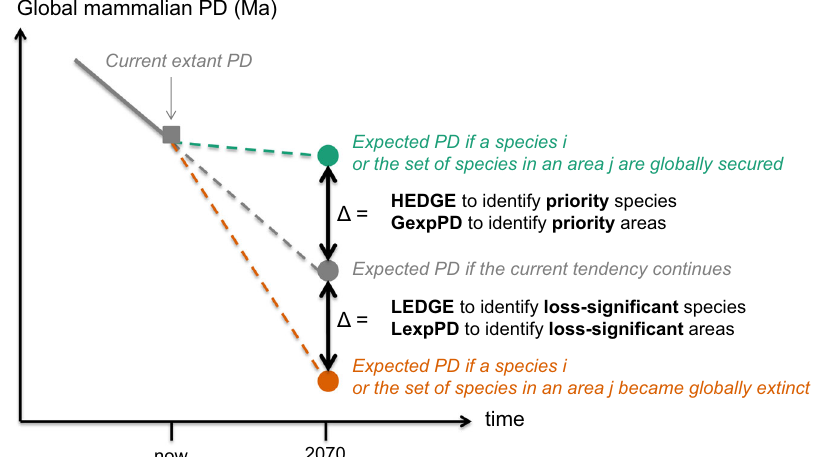
Fig. 1 Conceptual framework to identify species and areas of interest for conserving global mammalian PD based on the effects our actions can have on expected PD. (conservation actions leading to species securing = green circle, no change in species trajectories to extinction = grey circle and threatening actions leading to species extinctions = orange circle). Typically, phylogenetically informed conservation priorities have been identi fi ed based on the amount of current extant (threatened) PD they represent (grey square), so focussing on averting losses. Here we identi fi ed priority species based on the gain in expected PD they can bring if globally secured (HEDGE score) and priority areas based on the gain in expected PD they can bring if all species of the area are globally secured (GexpPD score), in a 50 year time horizon. We also identi fi ed loss-signi fi cant species based on the loss in expected PD they can trigger if they became globally extinct (LEDGE score) and loss-signi fi cant areas based on the loss in expected PD they can trigger if all species of the area became globally extinct (LexpPD score) in a 50-year time